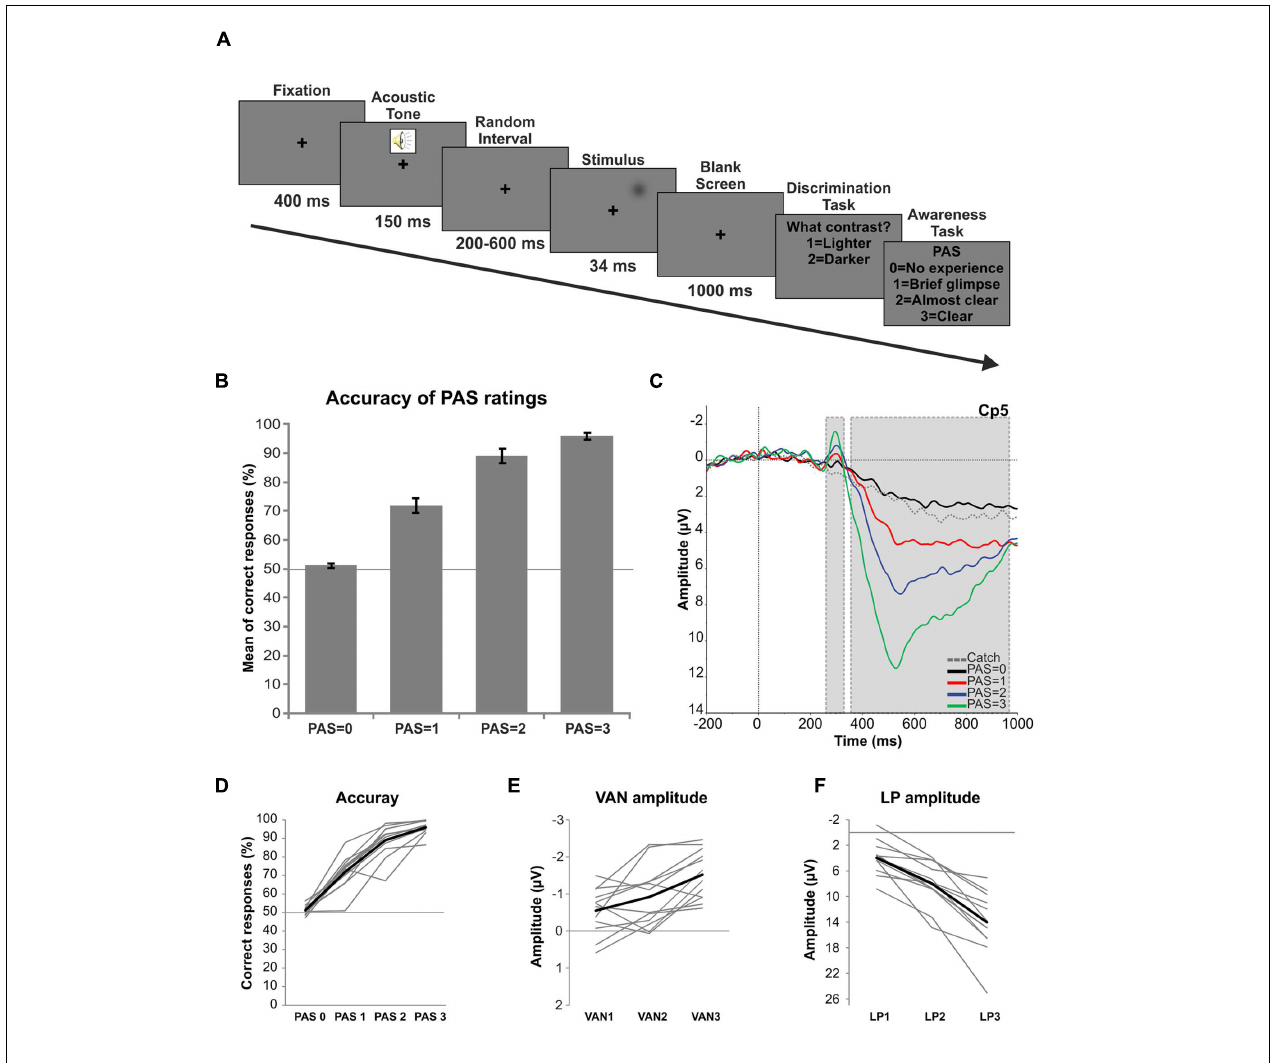
FIGURE 1 | Trial procedure and results. (A) Experimental procedure: first, a fixation cross was presented for 400 ms followed by a warning acoustic tone lasting 150 ms. Then, a random interval ranging from 200 to 600 ms preceded the stimulus presentation (34 ms) in the periphery of the right visual field. After a 1000 ms pause participants had to discriminate the brightness of the stimulus (Discrimination task) and then rate the clarity of their perception on the PAS (Awareness task). (B) Behavioral results: mean percentage of correct responses for each level of the PAS. Error bars represent standard errors and the solid line (50%) chance level. (C) ERPs: grand average ERPs in response to each category of the PAS and catch trials for electrode Cp5. Gray dotted boxes indicate the components of interest (respectively VAN and LP). (D) Single subject behavioral data. The thick black line represents the mean of accuracy. (E) Single subject amplitudes of the VAN component as a function of the differences between each conscious condition (PAS = 1, 2, and 3) and the unconscious condition (PAS = 0). The thick black line represents the average of single subject amplitudes. (F) Single subject amplitudes of the LP component as a function of the differences between each conscious condition (PAS = 1, 2, and 3) and the unconscious condition (PAS = 0). The thick black line represents the average of single subject